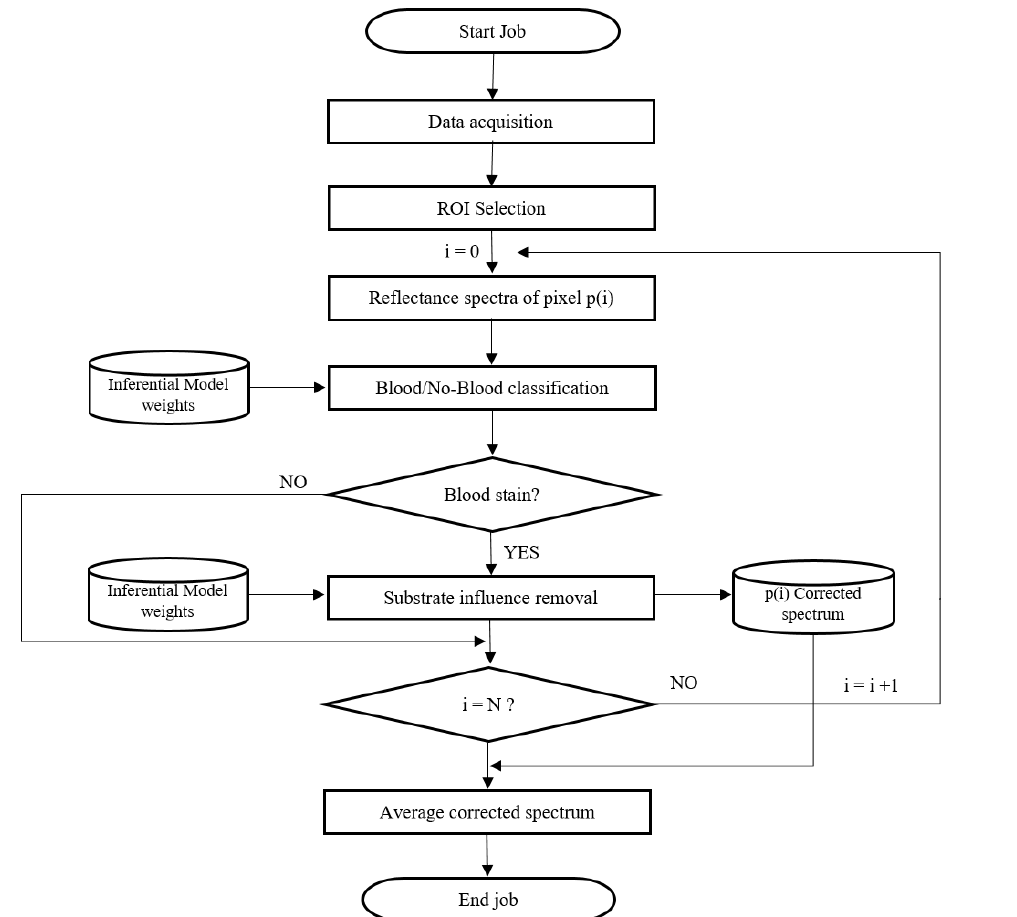
Figure 7. Procedure workflow for the blood stain classification and for the correction of the substrate spectral distortion in the blood stain reflectance